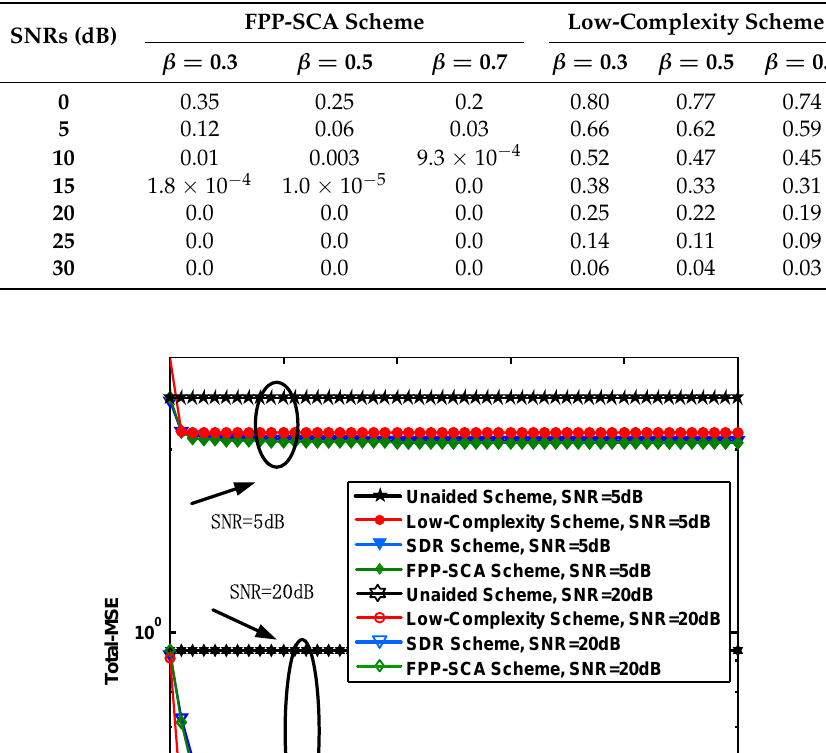
Table 1. The effects of β variation.